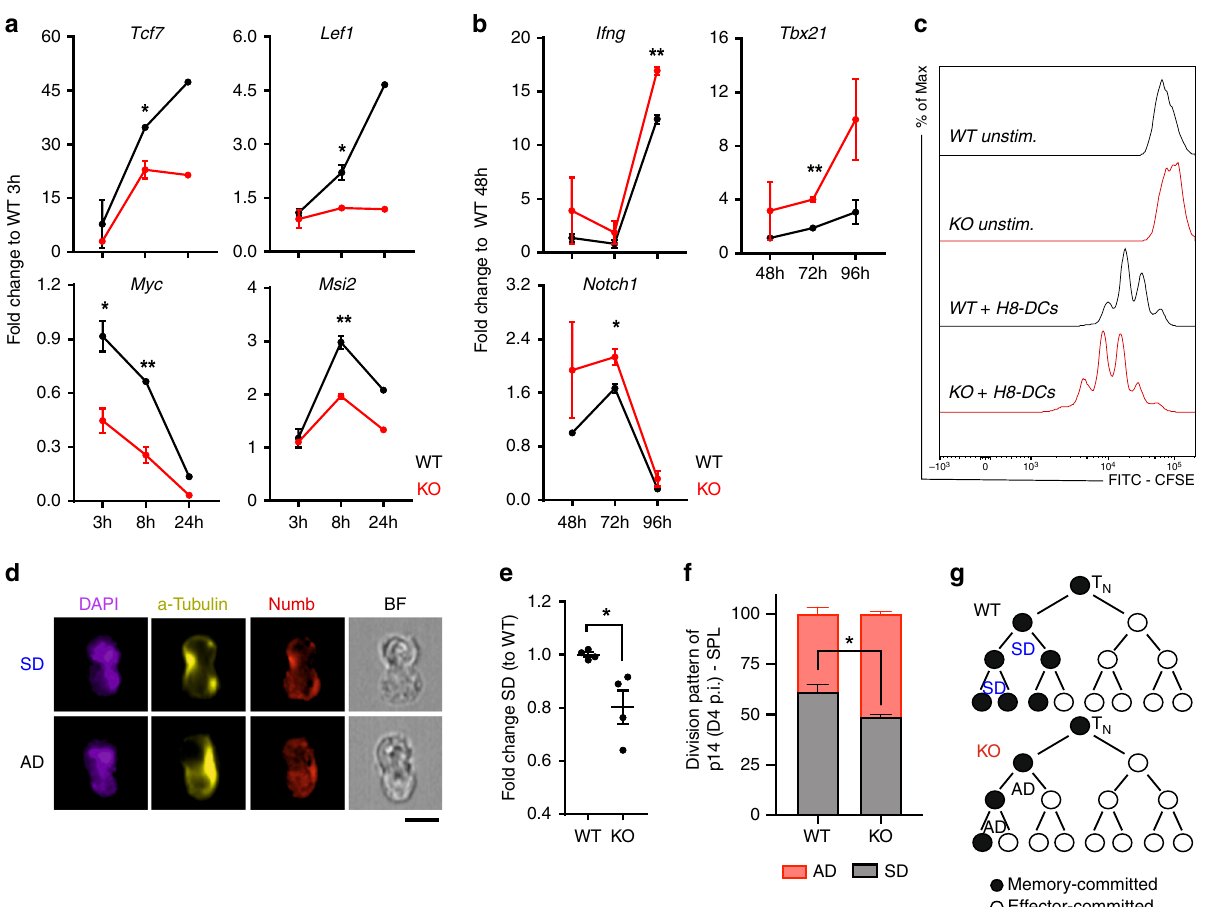
Fig. 6 TNIK signaling activates the Wnt pathway and favors symmetric cell division. a , b WT (black) and KO (red) p14 T cells were co-cultured with mature bone marrow-derived H8-DCs (H8-DCs) (1:1 ratio). Relative gene expression of indicated genes in FACS-puri fi ed p14 T cells is shown 3 – 96h post activation. One out of two independent experiments is shown. c CFSE dilution of WT or KO p14 T cells after 72h of co-culture with mature H8-DCs. Representative data from two independent experiments is shown. d ImageStream X analysis of Numb segregation in mitotic p14 T cells after 48h of co- culture with H8-DCs; scale bar 10 μ m. Analysis includes a total of 375 – 499 dividing mitotic cells. Representative nuclear stain (DAPI), α -tubulin stain, Numb stain and bright fi eld (BF) depict symmetric division (SD) vs asymmetric division (AD); scale bar 10 μ m. e Numb segregation per each culture replicate ( n = 2 – 3) and frequencies of SD vs AD were assessed. Fold change of SD frequency normalized to average of WT control group is depicted. Pooled data from two independent experiments is shown (two replicates per timepoint). f ImageStream X analysis of Numb segregation in mitotic AdTf p14 T cells isolated of spleens 96h p.i. Frequency of AD vs SD of total dividing WT and KO p14 T cells is shown. Analysis includes a total of 192 (KO) and 186 (WT) dividing mitotic cells from three pooled mice per replicate ( n = 4). g Model of cell fate in KO vs WT T cells. Three cell division steps are observed within 48h post activation. Data are displayed as means±SEM. Depicted: WT p14 (black lines/circles), KO p14 (red lines/circles). Statistics: a , b , e , f two-tailed Student's